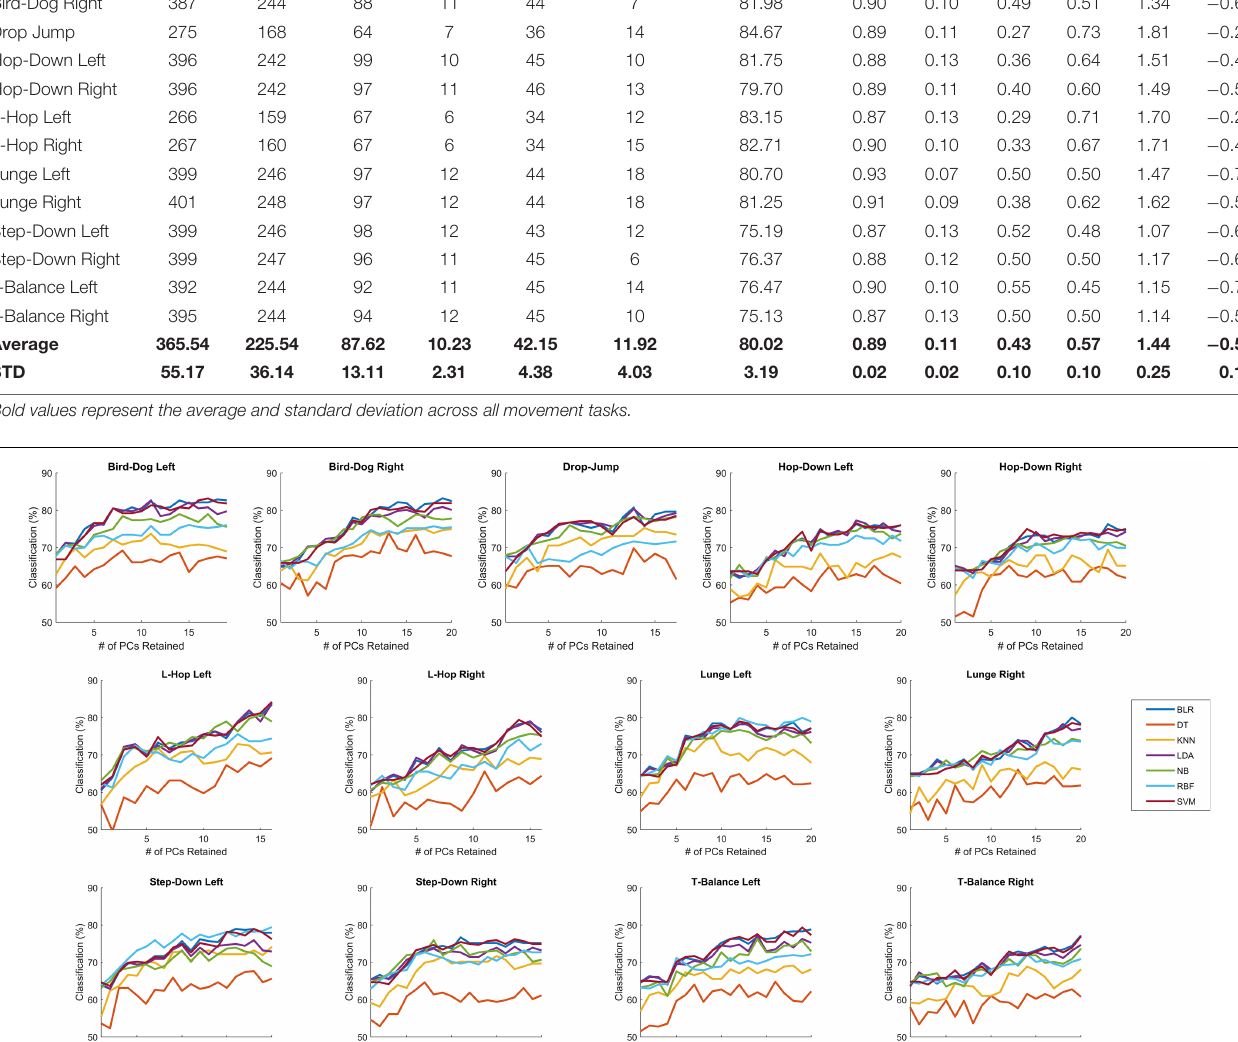
retained ranged from 9 (hop-down right) to 18 (bird-dog left, T-balance right) with an average of 14.15 ± 3.02 PCs retained ( Table 1 ). The OMAT-OPT accurately classified between 73.1% (T-balance right) to 83.8% (L-hop left) of athletes as either elite or novice ( Table 1 ). The average classification rate across all tasks was 78.1% ± 3.26%. For SDT, on average, OMAT-OPT had a hit, miss, FA, and CR rate of 0.87 ± 0.03, 0.13 ± 0.03, 0.38 ± 0.06,